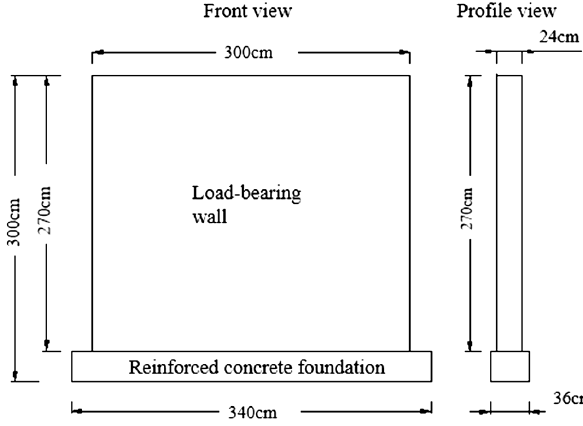
Figure 1. Experiment setup. Figure 2. Sketch of load-bearing